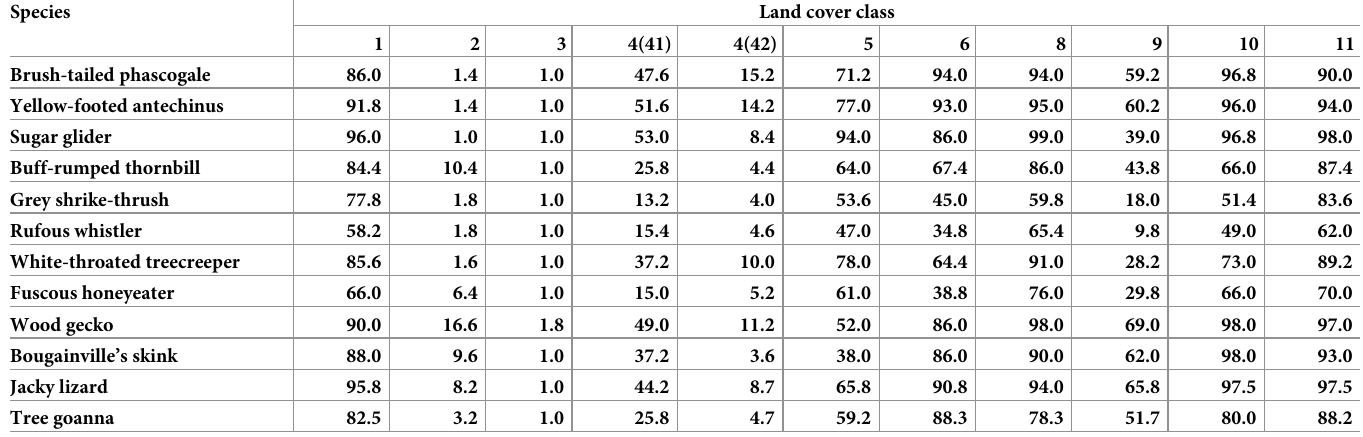
Table 1. Resistance scores for each species for each land-cover class in the study area. Scores are the average of the values assigned by the experts. A higher score indi- cates greater resistance to the movement of a species through that land-cover class. Land cover classes include (1) Dryland pasture; (2) Dense forest cover; (3) Woodland and open forest; (4) Open woodland (which was split into 41 Open woodland–open woodland with numerous gaps and 42 Open woodland–where canopy vegetation is relatively continuous); (5) Temperate grassland and chenopod shrubland; (6) Urban–suburbs; (8) Irrigated crops, pasture and horticulture; (9) Plantation forestry; (10) Waterbodies and wetlands; and (11) Dry-land